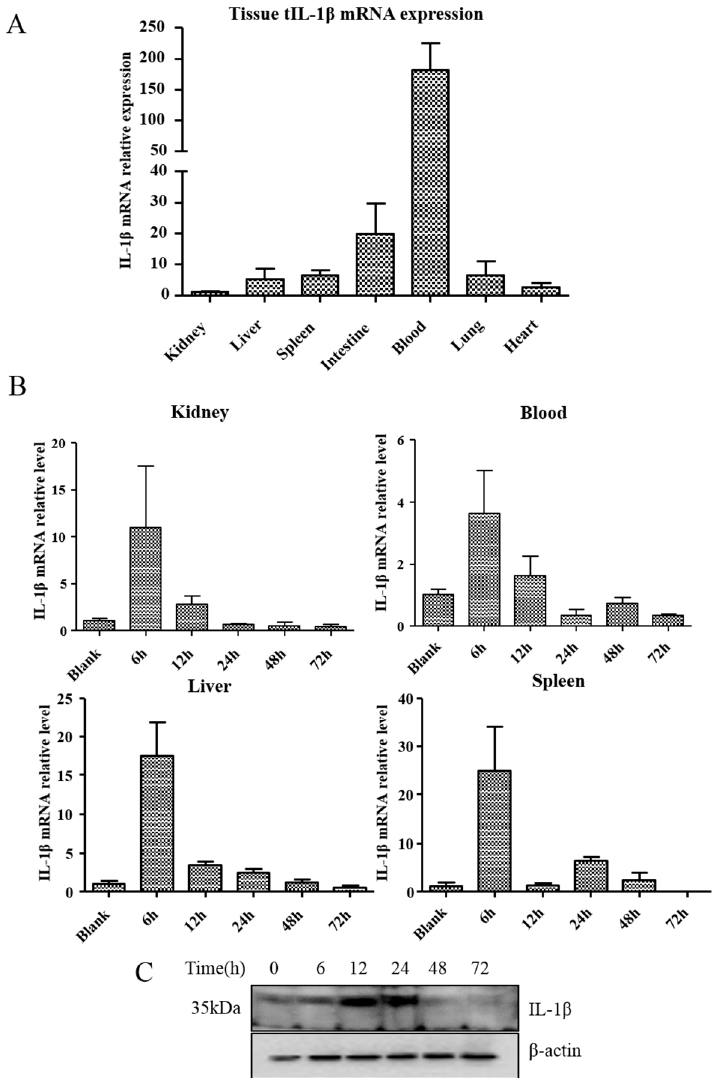
Figure 5. Analysis of the tissue expression of P. sinensis IL ‐ 1 β in clinically healthy turtles (A) or Aeromonas hydrophila ‐ infected turtles (B,C). ( A ) Quantitative PCR was performed using primers specific for tIL ‐ 1 β with cDNA extracted from different tissues. β‐ actin was used as internal control and the results were normalized relative to the expression level in kidney. The results were shown as mean ± SEM of five turtles; ( B ) The mRNA levels relative to β‐ actin in kidney, blood, spleen and intestine from infected turtles were normalized with the mock group ( i.e. , uninfected turtle tissue) set at 1.0; ( C ) Protein extracted from spleen samples of infected turtles were subjected to western blotting for tIL ‐ 1 β and β‐ actin.